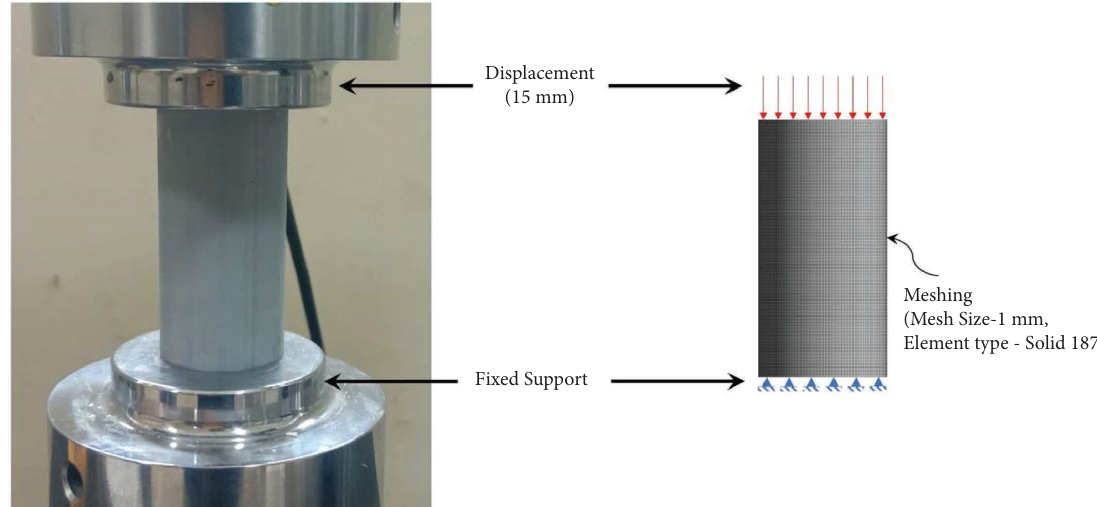
Figure 7: Te testing sample boundary condition in the (a) machine and (b) simulation through a virtual environment.